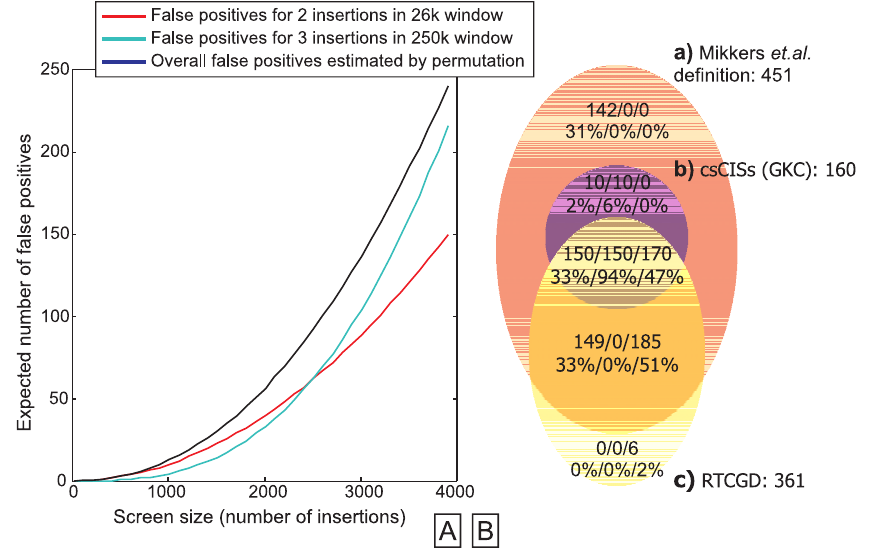
Figure 6. Comparison with Previous CIS Definition (A) Plot of the increase of the error as a function of the screen size, when using the definition from [8], computed using the Poisson distribution, or a permutation approach. Also the results from the two individual windows used are given. Since the errors made by the two windows individually are not mutually exclusive, the Poisson estimate is an overestimate of the true error. (B) Venn diagram comparing three different CIS definitions: a) the definition from [8] applied to the complete dataset, b) the csCISs resulting from the GKC, and c) the published CISs from the RTCGD. The intersection between sets shows three counts (and corresponding percentages), indicating the count for set a, b, and c, respectively. This is because the three sets of CISs used different definitions (at different scales) for a CIS, so that some CISs are split up, and hence are counted twice.